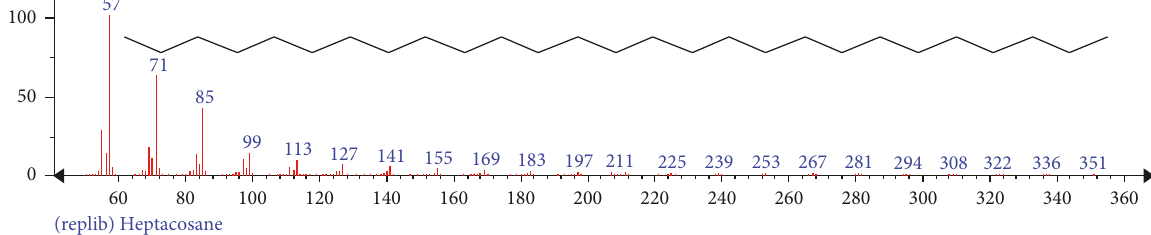
Figure 52: Mass spectrum of compound heptacosane of whole plant hexane fraction of Achillea wilhelmsii (WHFAW).